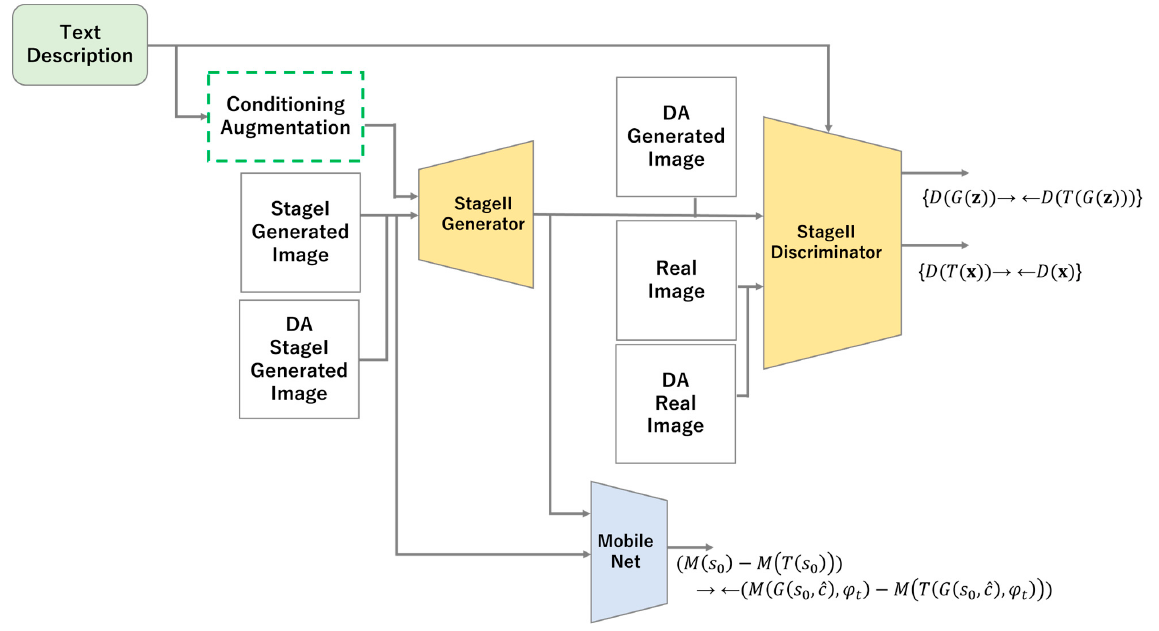
Figure 6. Model diagram of Stage II in StackGAN with ICCR.